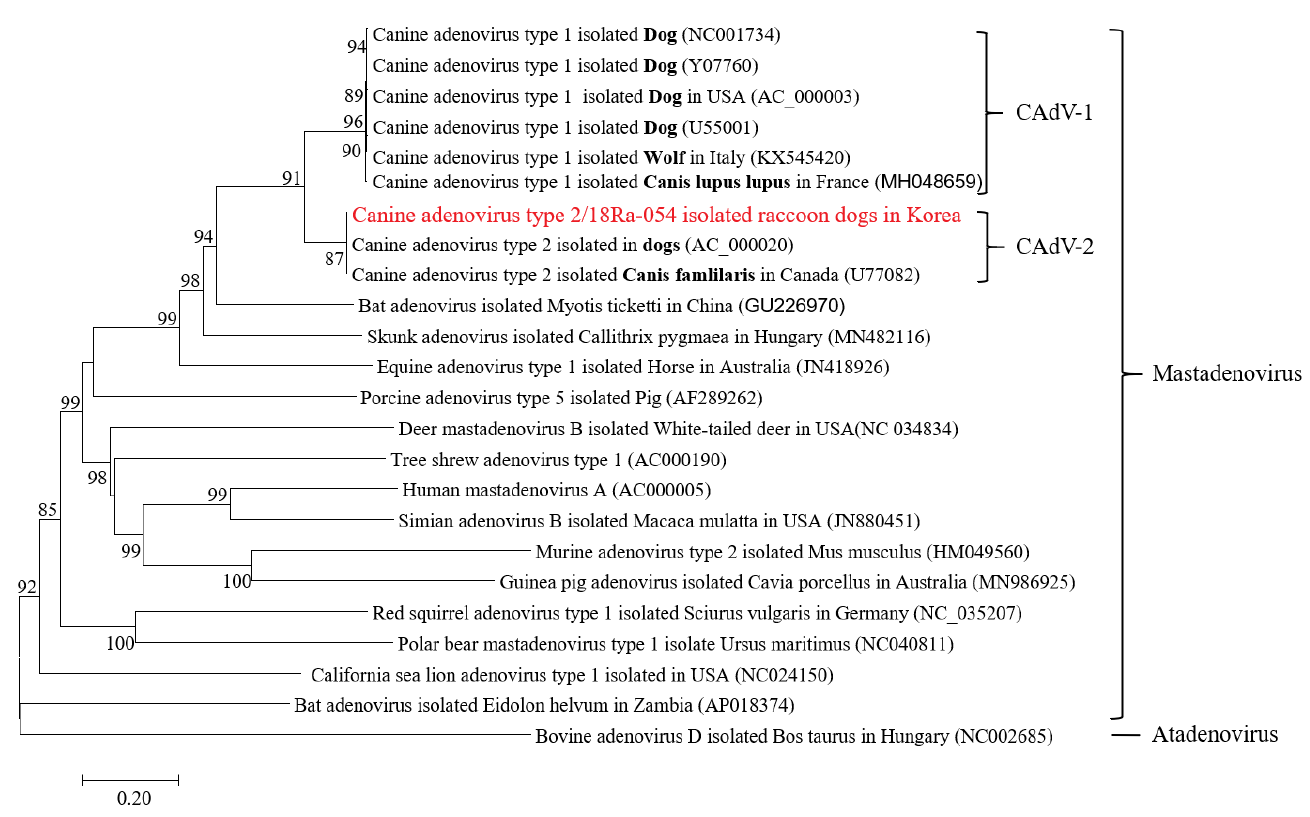
Figure 3. Phylogenetic tree of the entire nucleotide sequences of CAdV-2/18Ra-54. The trees were produced using the NJ method and were bootstrapped with 1000 rep- licates. The branch lengths indicate the numbers of nucleotide substitutions per site. The sequences from this study are indicated in bold. Only bootstrap values at or above a 50% rate are shown.